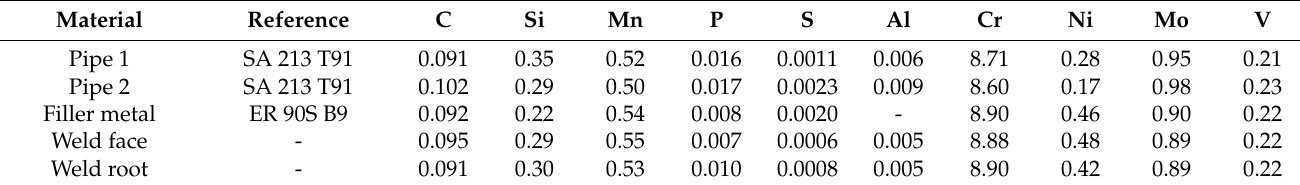
Table 8. Chemical analysis of the materials used in the welding and weld composition (wt